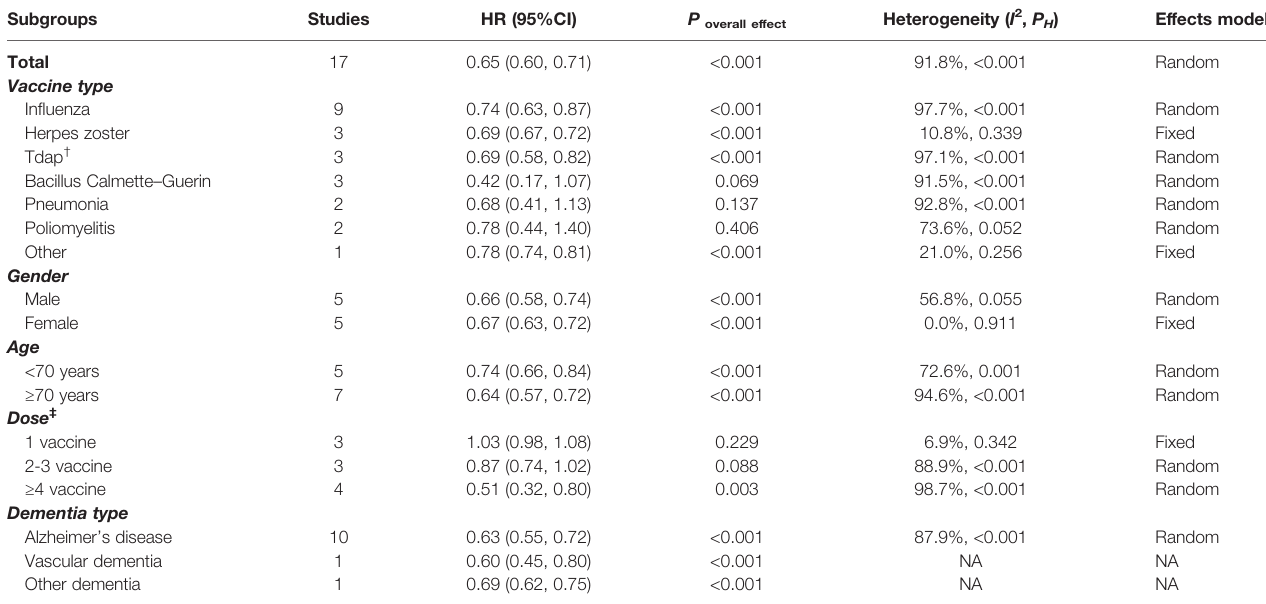
TABLE 3 | Subgroup analysis of the association between vaccination and dementia risk.